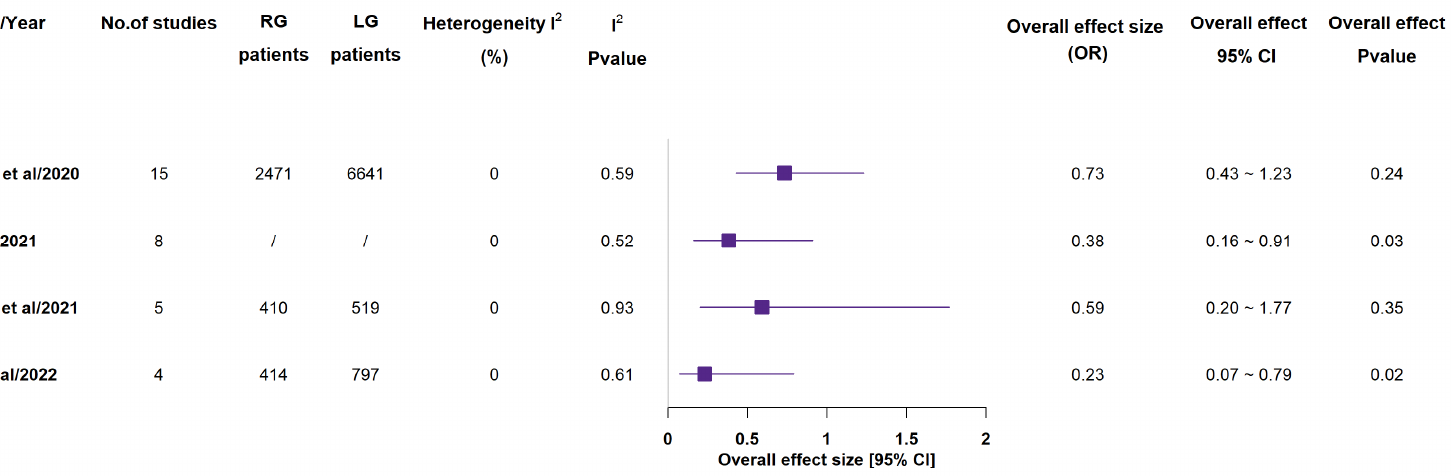
Figure 10. Pancreatic complications rate. RG = Robotic gastrectomy; LG = Laparoscopic gastrectomy; OR = odds ratio